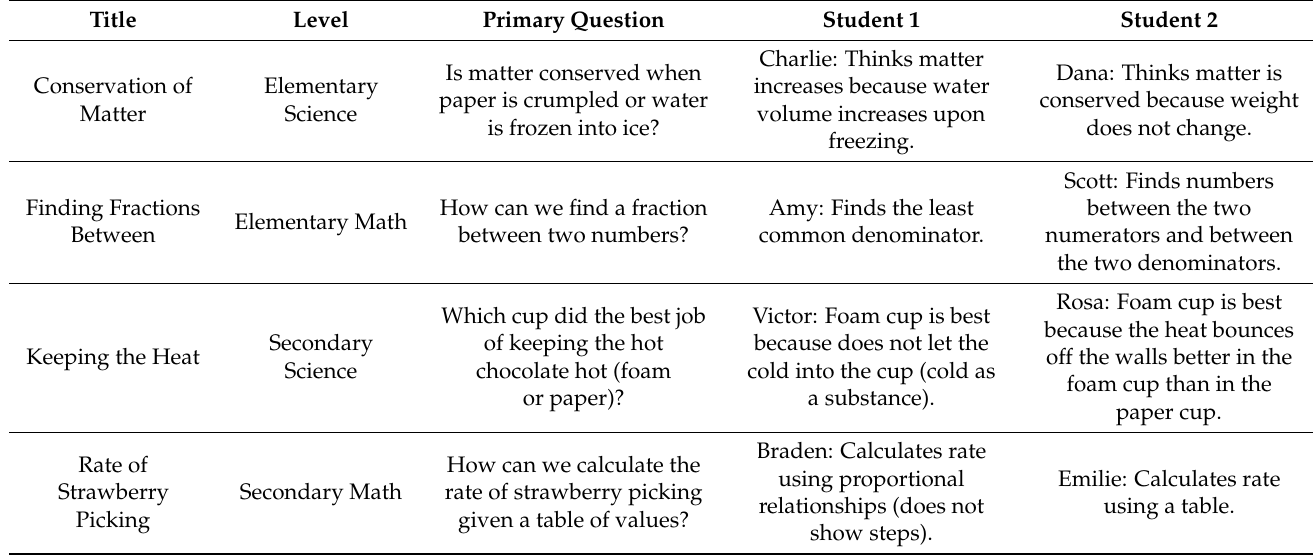
Table 1. Summary of ELK simulation